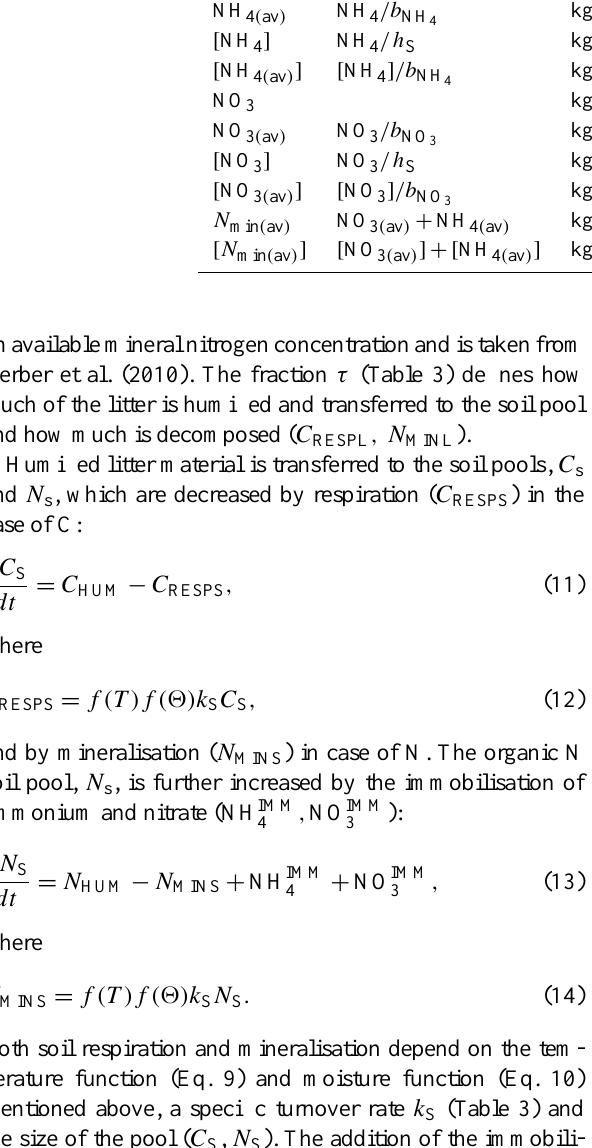
Table 4. Relationship between different expressions of mineral N pools and concentrations. Values for h S , b NH Table 3.